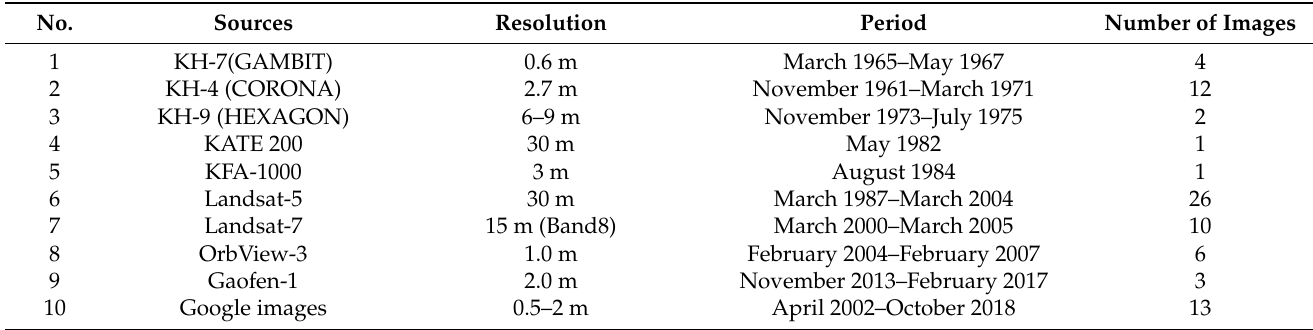
Table 1. Remote sensing data adopted in the study.